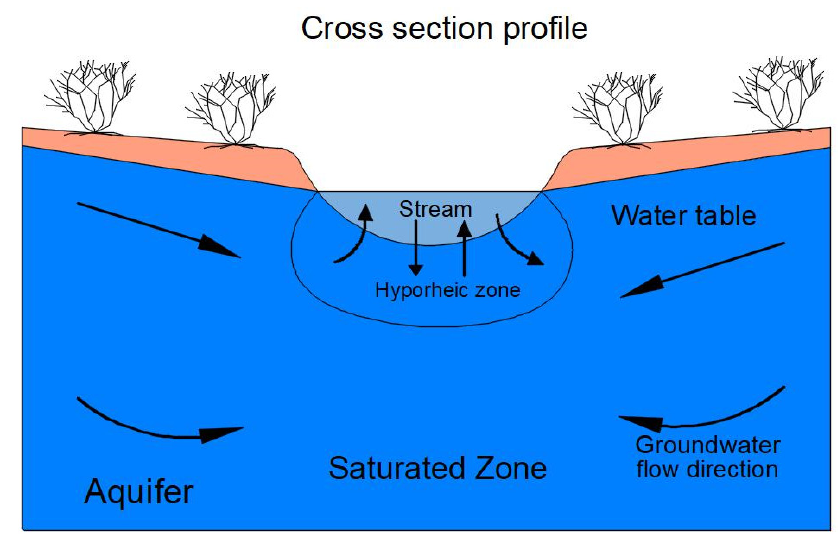
Figure 6. Processes occurring in the Hyporheic Zone. The black arrows represent the fluid flow directions.